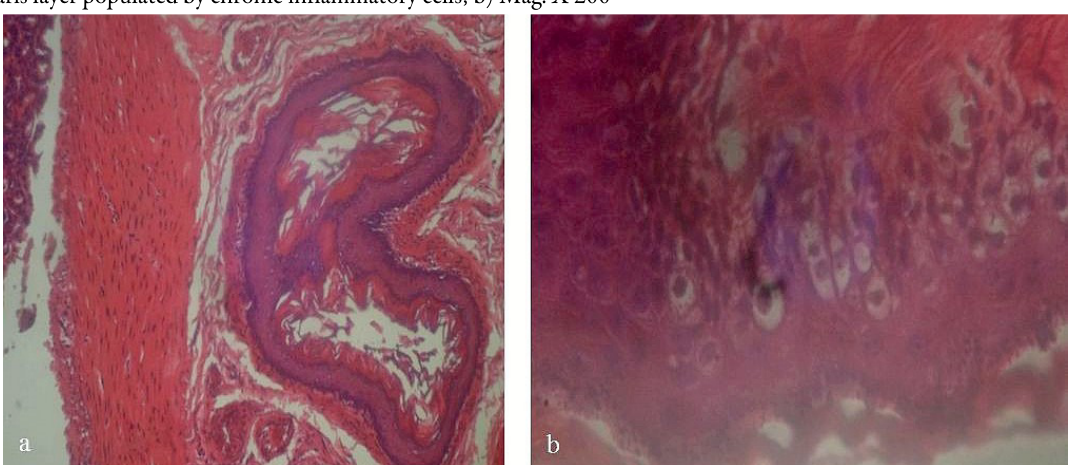
Fig. 7. Uninduced and untreated. The Photomicrograph shows G.I.T. section with longitudinal muscle hyperplasia, keratinized epithelium and with high degree squamation; a) Mag. X 200 and koilocytes with some hyperchromatic cells with dense nuclei; b ) Mag. X